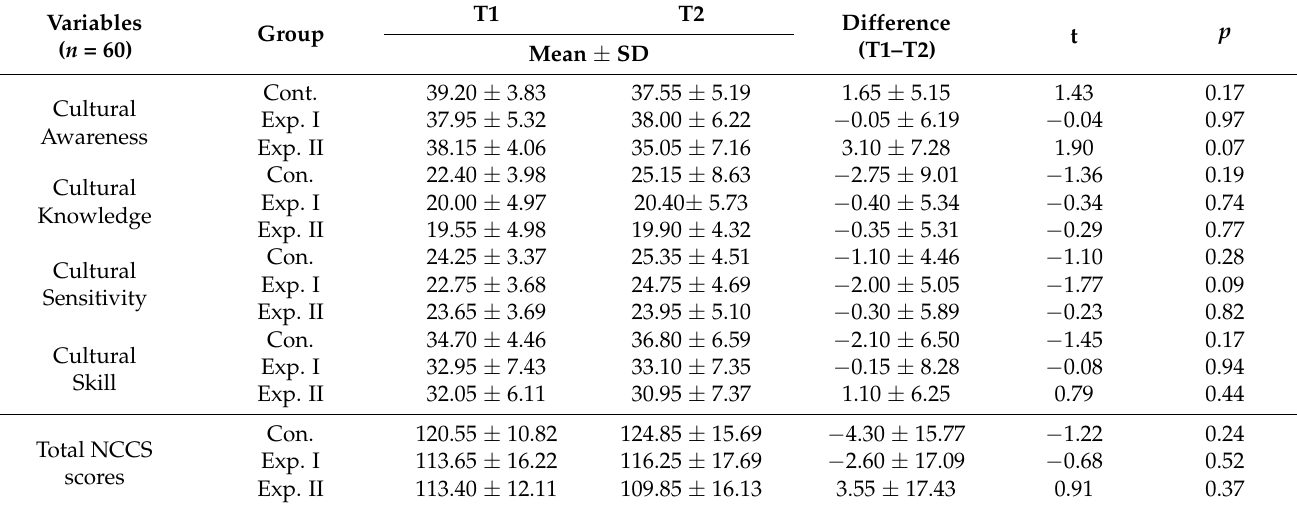
Table 3. The Comparison of NCCS scale and subscales between baseline and pre-test (N =